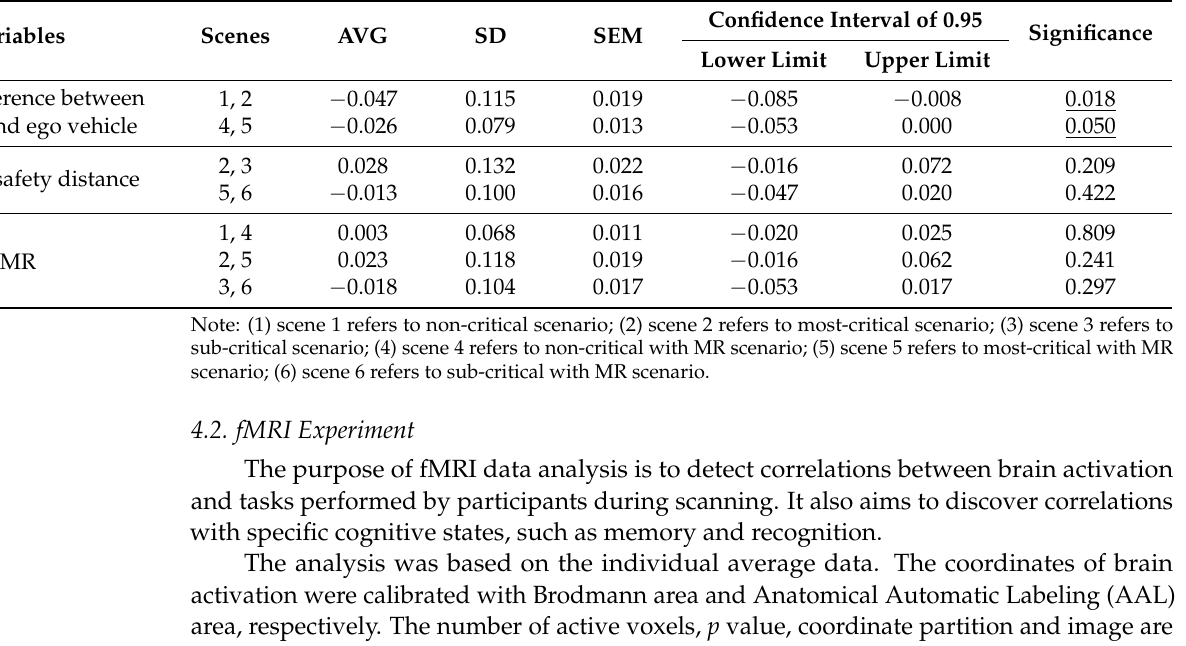
Table 10. Paired sample t -test of standard deviation of lateral displacement within 5 s after taking